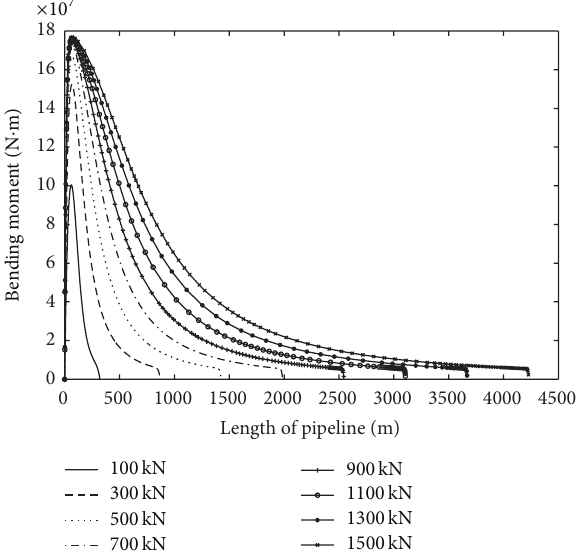
Figure 5: Bending moments of the suspended pipeline in the first case.